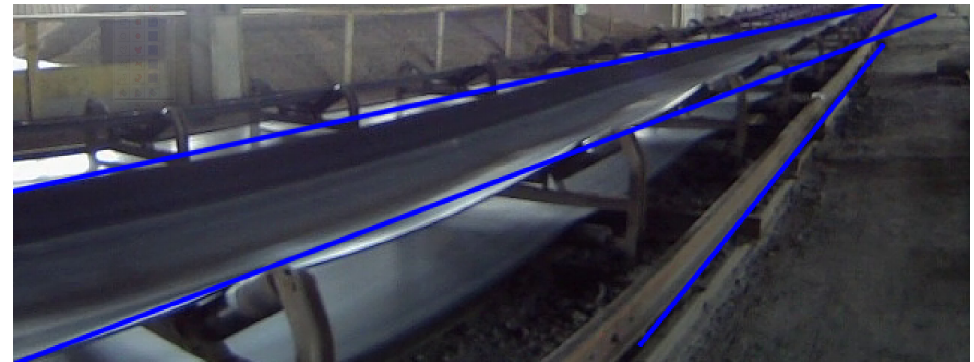
Figure 8. Exemplary effect after line grouping.